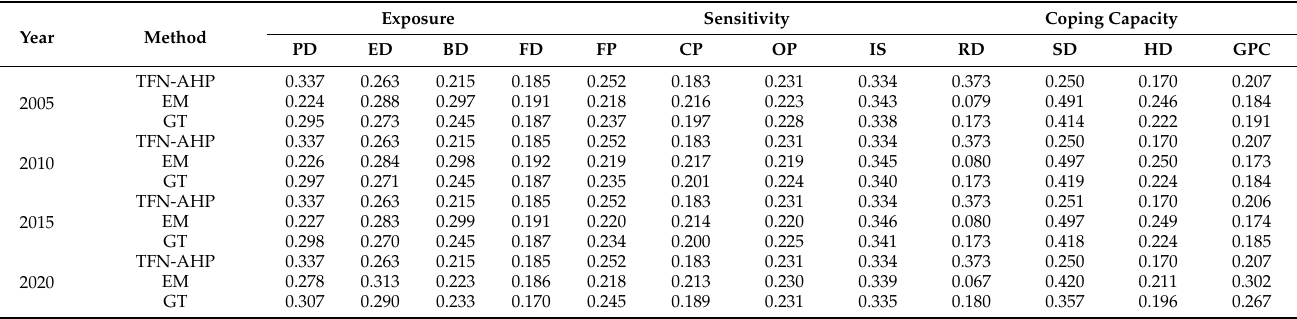
Table 5. Vulnerability index weights obtained via the three